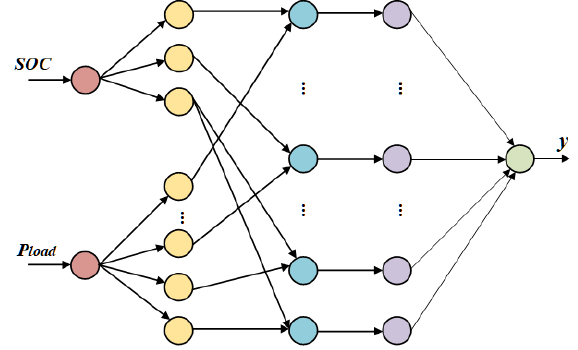
Figure 11. Simplified fuzzy neural network controller.